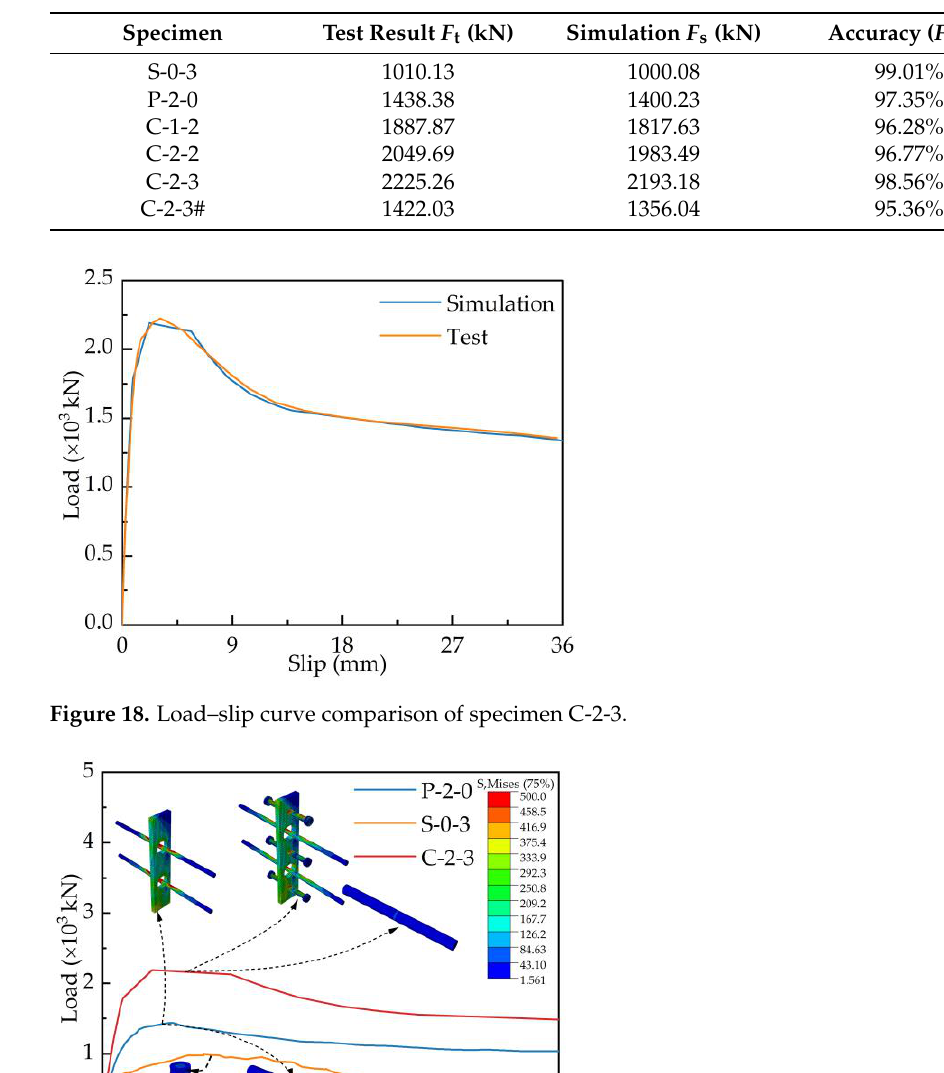
Table 6. Accuracy of simulated shear resistance.